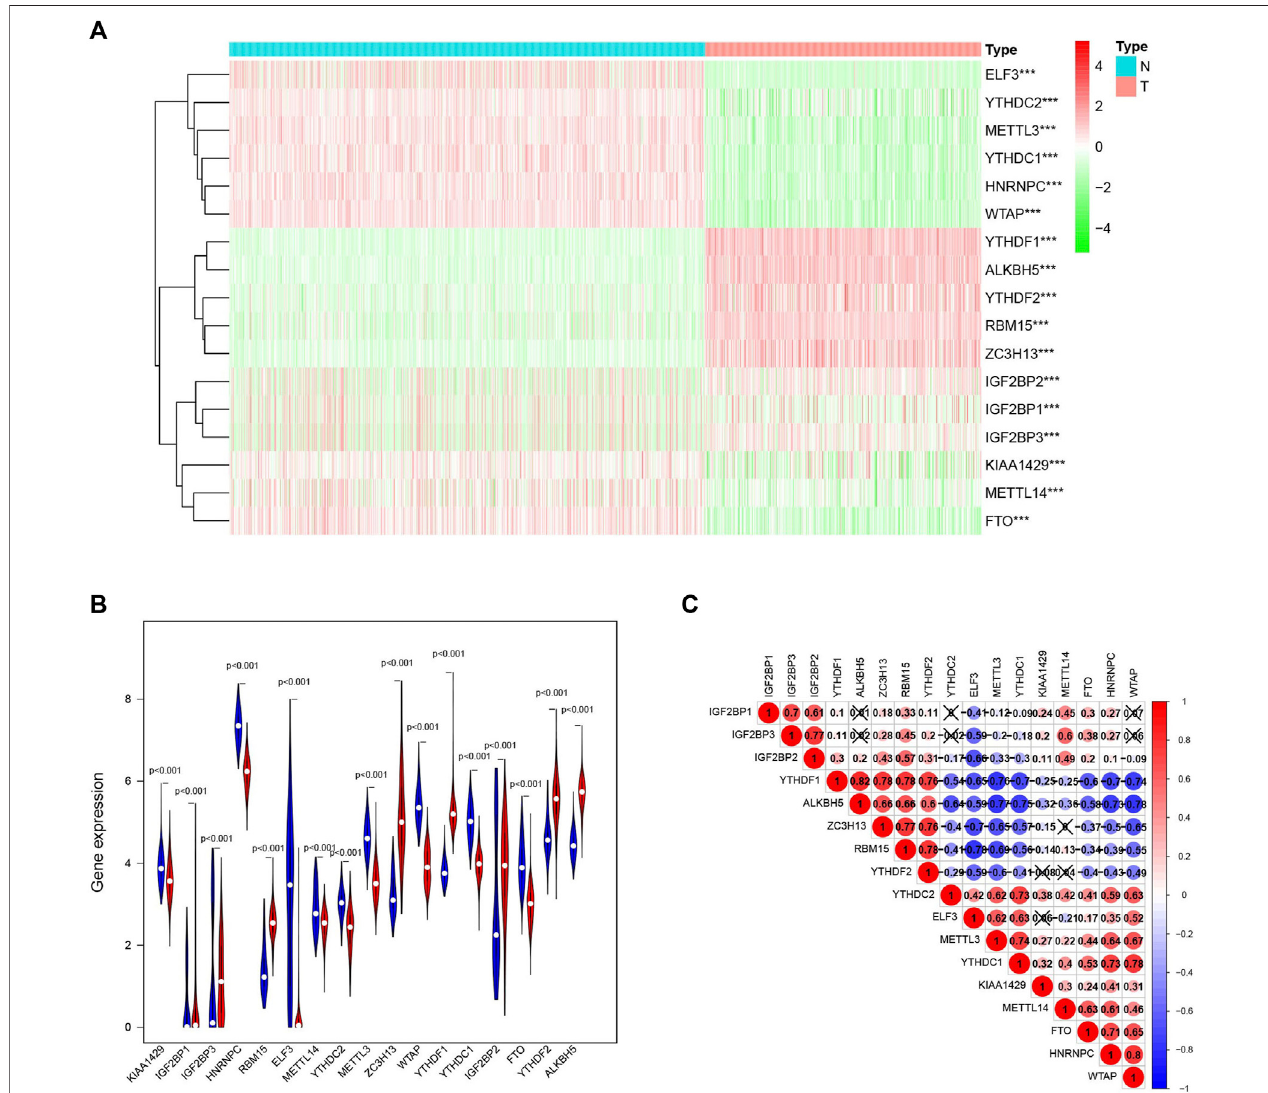
FIGURE 2 | The expression characteristics and correlations of m 6 A RNA methylation regulators in melanoma. (A) Heatmaps presented the overall expression of 17 m 6 A RNA methylation regulators in melanoma tissues and normal tissues from The Cancer Genome Atlas (TCGA) and The Genotype-Tissue Expression (GTEx) datasets p < 0.05 ( “ * ” ), p < 0.01 ( “ ** ” ), and p < 0.001( “ *** ” ) (B) The differential expression of the m 6 A RNA methylation regulators was visualized by vioplot (blue means normal skin tissues, red means melanoma samples). (C) The interaction of the 17 m 6 A RNA methylation